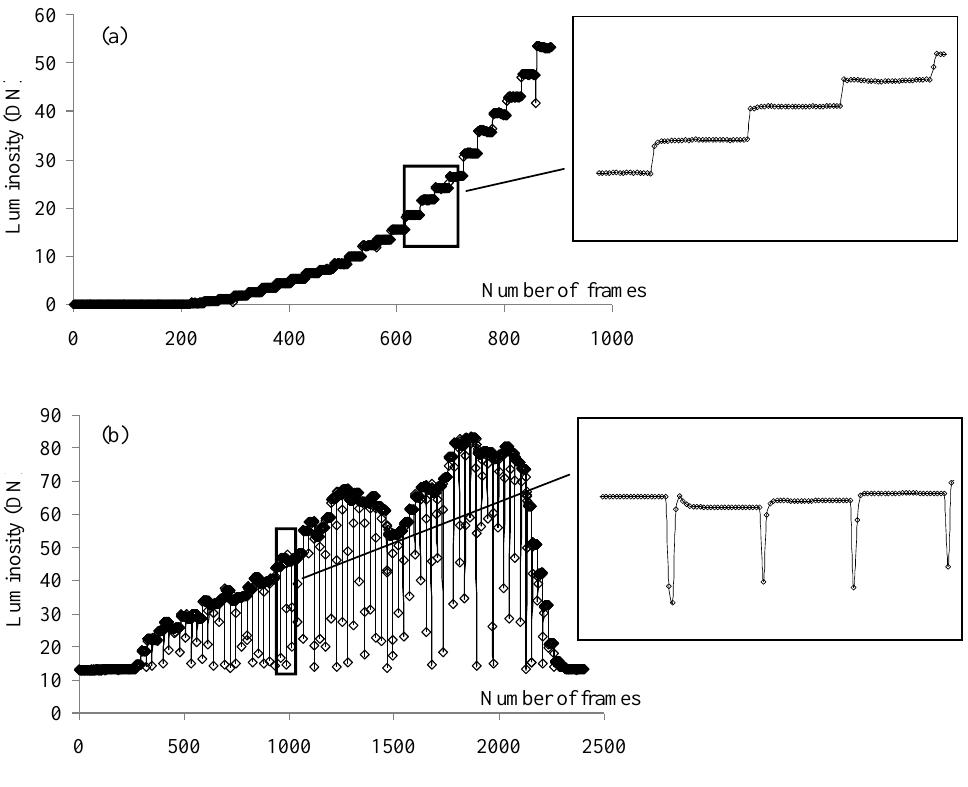
Figure 3. Luminosity trend within an acquisition cycle with filters ( a ) VIS and ( b )